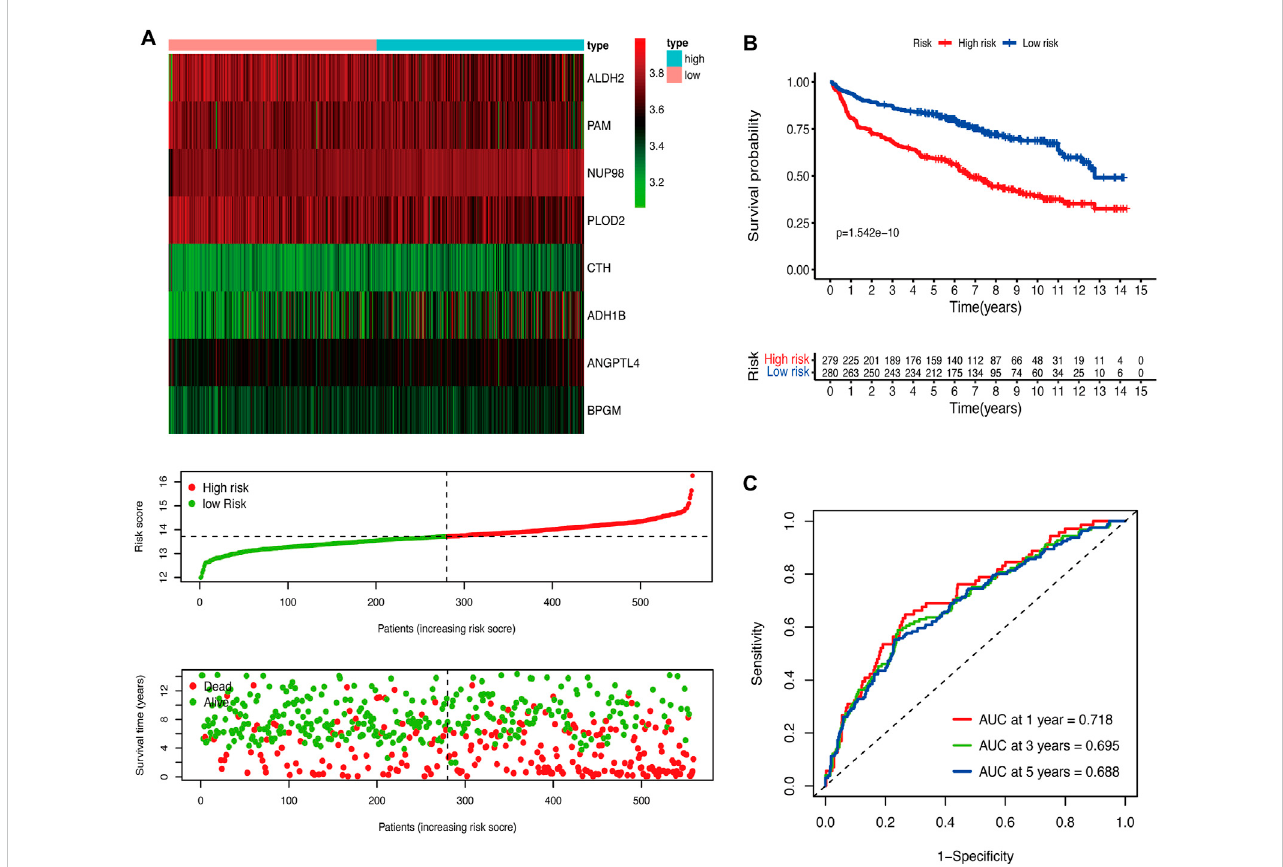
FIGURE 2 ConstructionoftheglycolyticriskmodelforpatientswithDLBCLinthetrainingcohort. (A) Glycolysis-relatedriskgeneexpression,riskscoredistribution, and survival status of patients in high- and low-risk groups. (B) Kaplan-Meier analysis of overall survival in different risk groups. (C) Time-dependent ROC analysis of the glycolytic risk model. DLBCL, diffuse large B-cell lymphoma; ROC, receiver operating